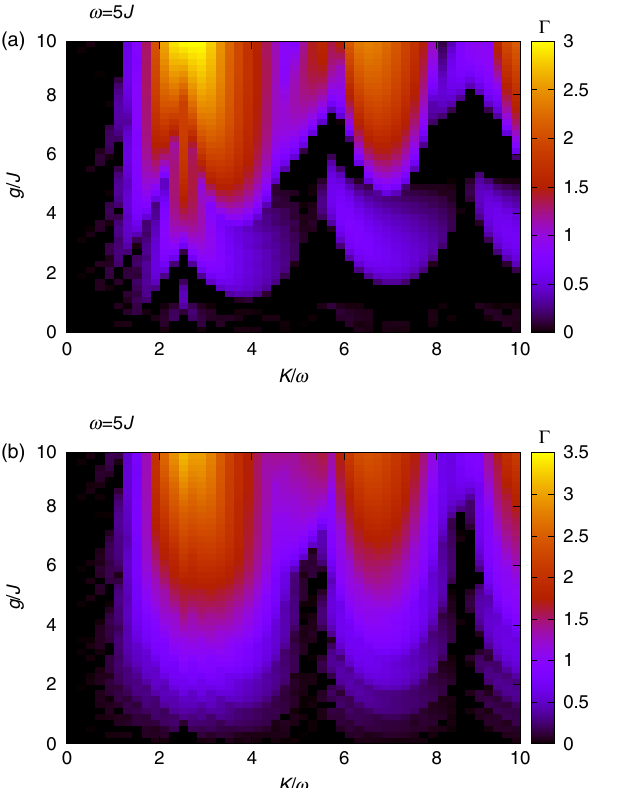
FIG. 11. Numerical instability rate as a function of interaction strength g ¼ U ρ and modulation amplitude K= ω , for ω ¼ 5 J (i.e., in the low-frequency regime) and for two different numbers of lattice sites in the transverse direction: N 16 (bottom panel). N y ¼